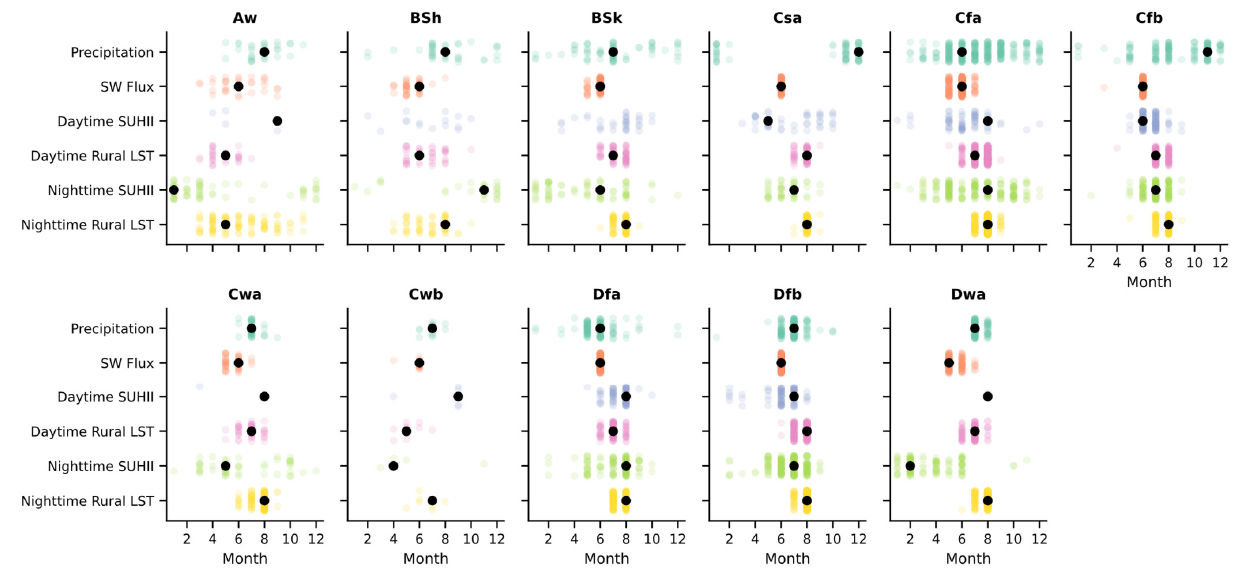
Figure 8. The month when SUHII, rural LST, SW, and precipitation are strongest per climate class. The colored dots represent the individual SUHII loops and the black dots the Köppen–Geiger climate-class mean loop (BSh and BSk are not included). Table 4. The minimum and maximum SUHII (and the 95% confidence intervals) for the Köppen– Geiger climate-class means shown in Figures 8 and 9 (black dots).